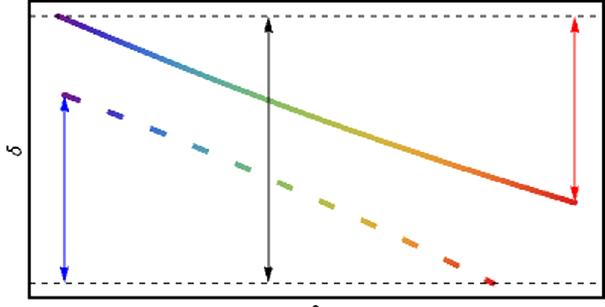
FIG. 5. Longitudinal phase spaces of accelerating (solid) and decelerating (dashed) bunches in an intermediate arc. The required energy acceptance for common transport corresponds to the height of the black arrow. The required energy acceptance in the corresponding separate transport configuration corresponds to only the height of the red and blue arrows for the accelerating and decelerating arcs respectively.